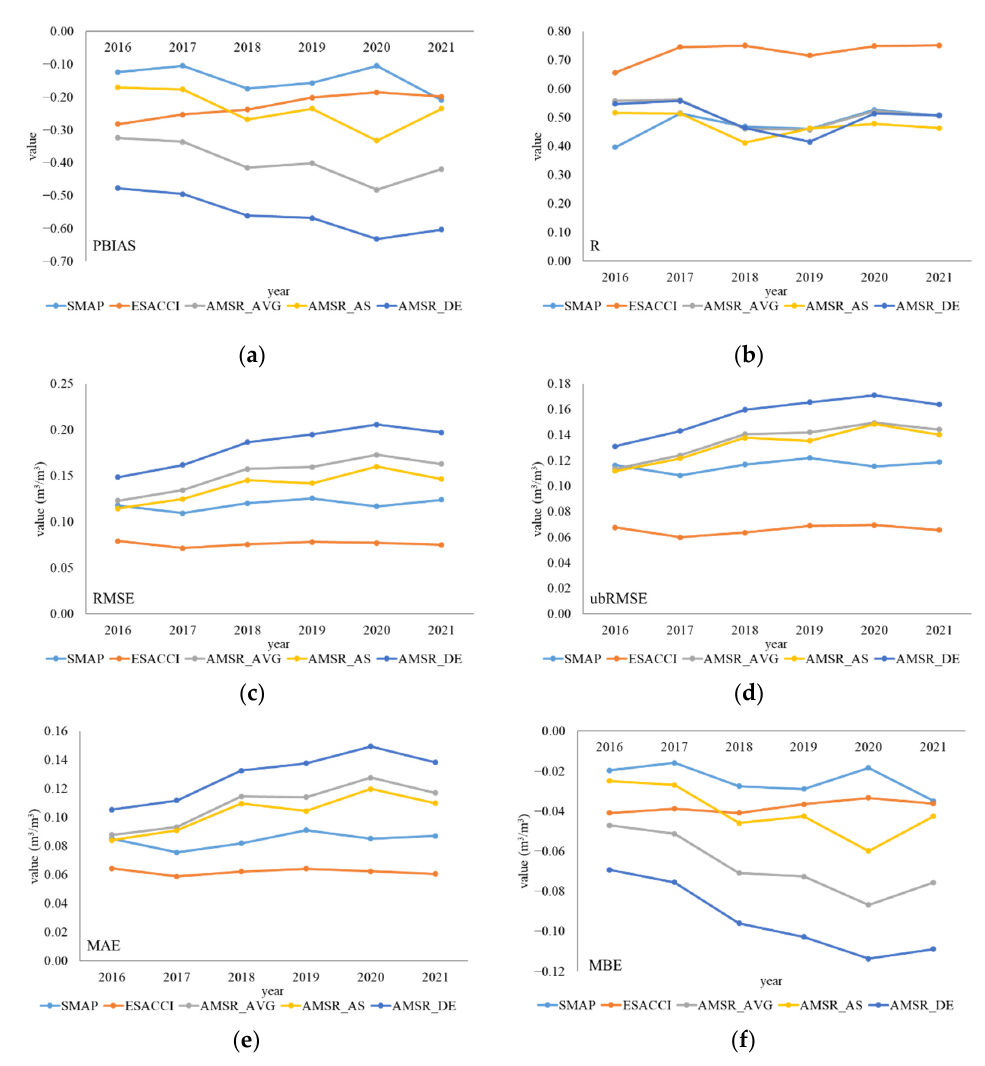
Figure 6. Performance of six indicators of five products at different years. ( a ) PBIAS; ( b ) R ( p -value < 0.0001); ( c ) RMSE; ( d ) ubRMSE; ( e ) MAE; and ( f ) MBE .